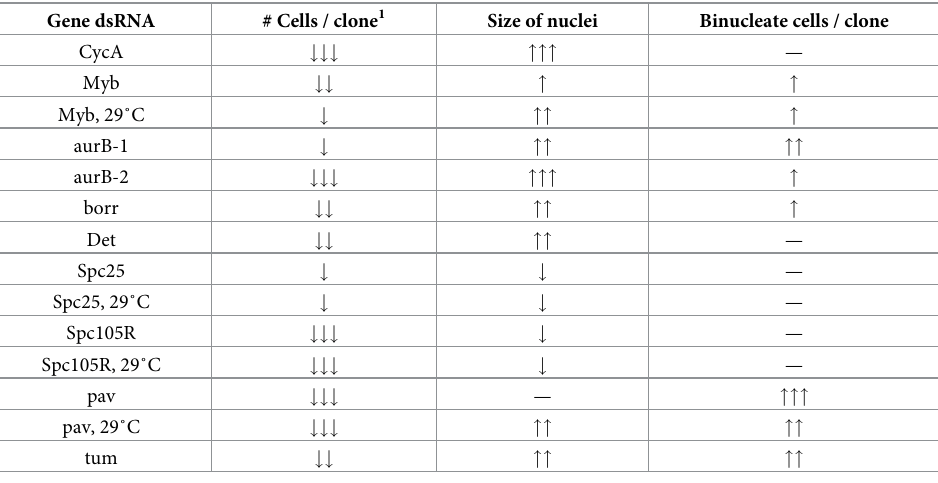
Table 2. Summary of follicle cell clone phenotypes. Gene